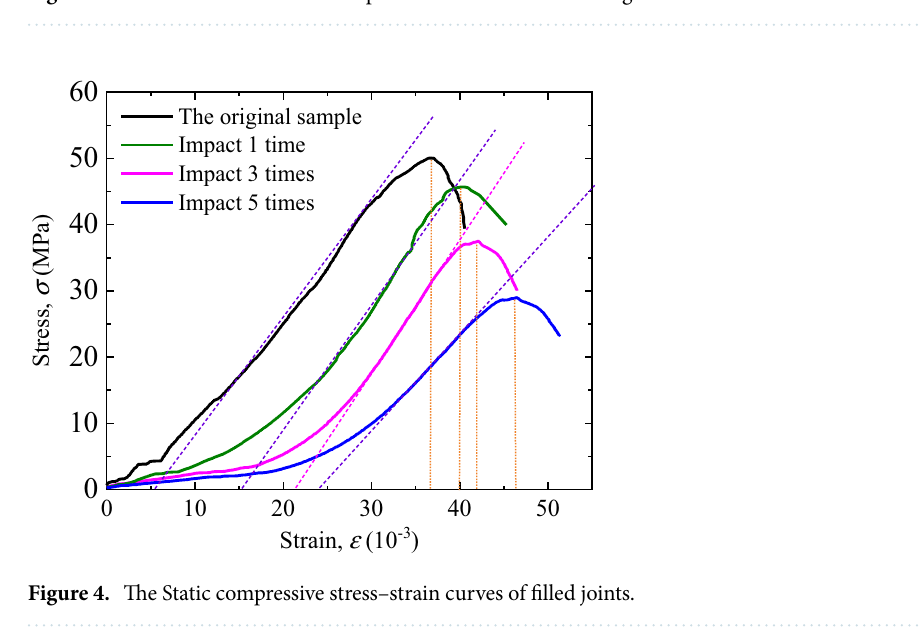
Figure 3. The WAW31000 microcomputer control universal testing machine.